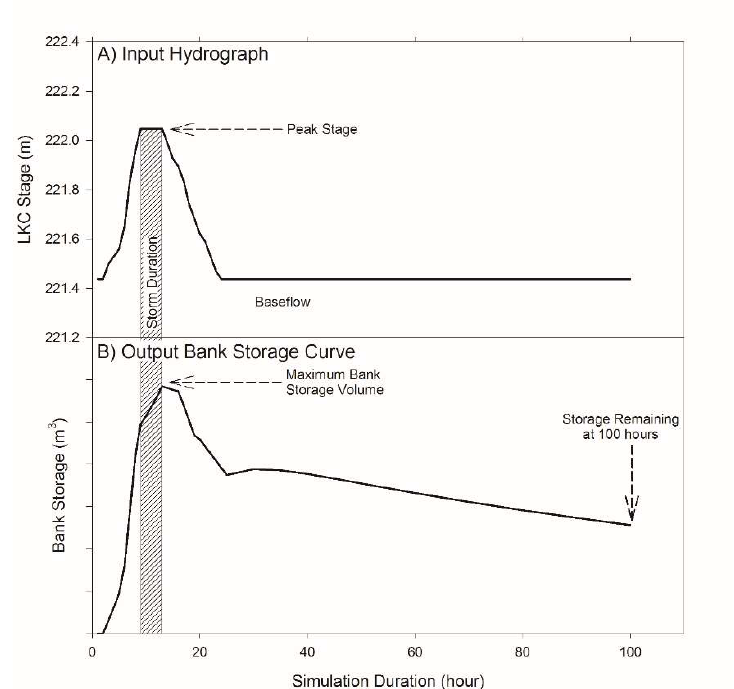
Figure 3. ( A ) Example of the input hydrograph used in the simulations; peak stage and storm duration are defined. ( B ) Example of an output bank-storage curve; the variables of maximum bank storage and the storage remaining after 100 h are defined on the curve.